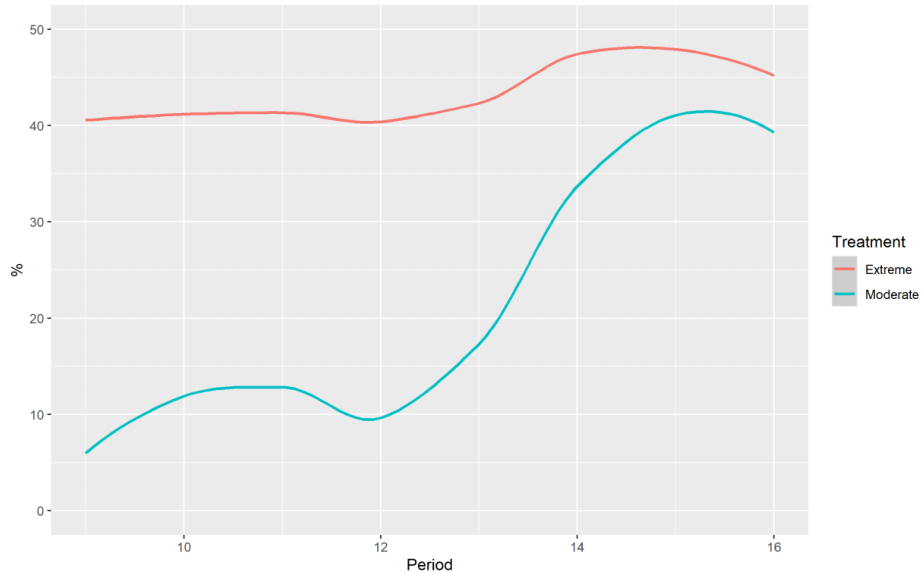
Figure 5. Voting decisions of the leftists and rightists.